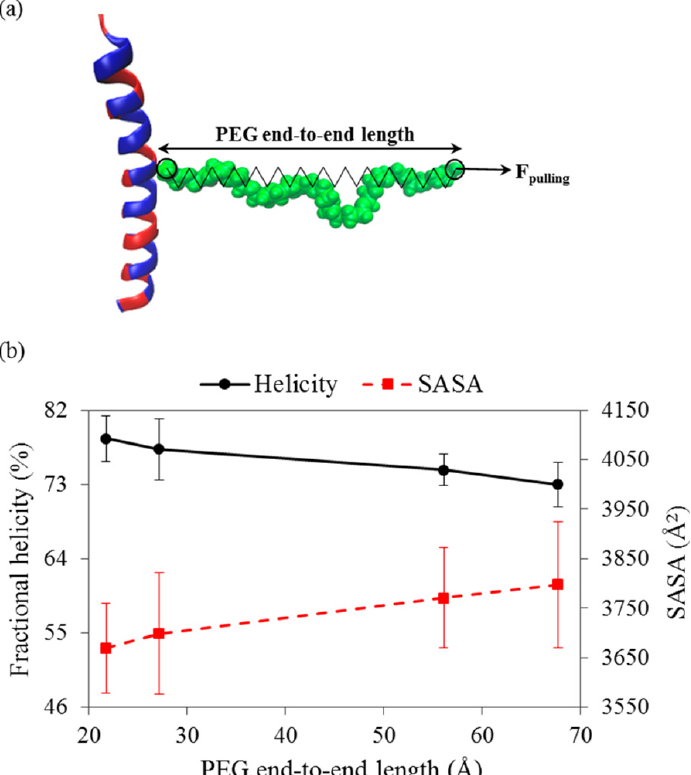
Figure 4. ( a ) Schematic of constant force pulling simulations, where the external force applies to the PEG chain ( M = 882); and ( b ) the peptide helicity and solvent accessible w surface area (SASA) as a function of the end-to-end distance of the grafted PEG. (Reprinted with permission from [95]. Copyright 2013 American Chemical